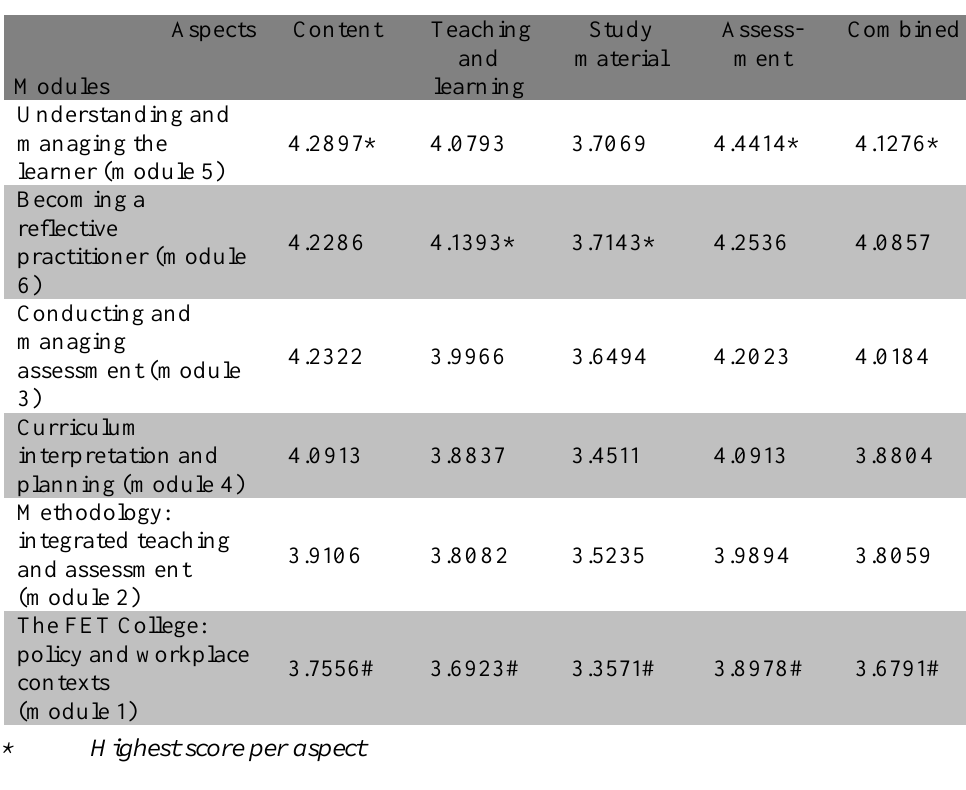
Table 4 Average Rating on Various Aspects, per Module (Ranked)